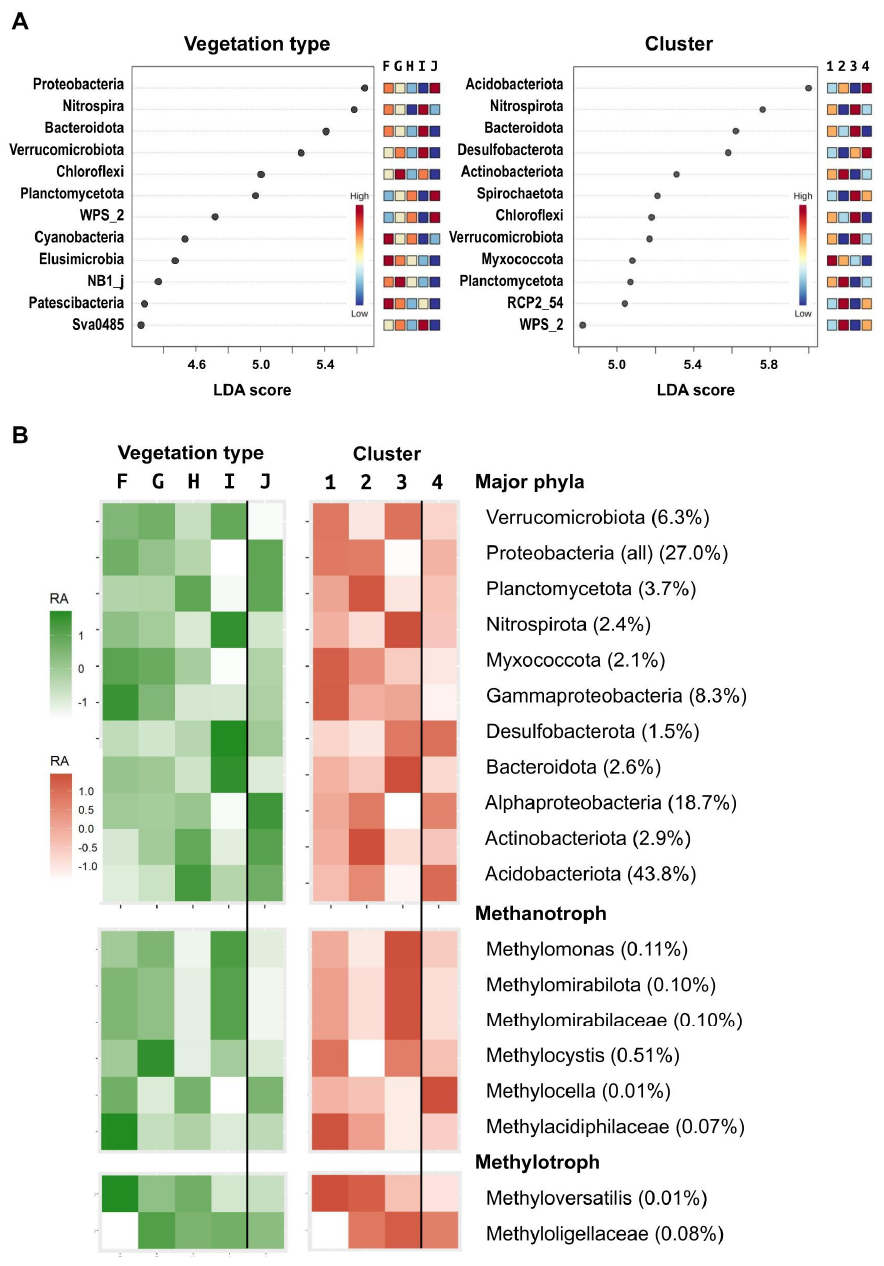
Figure 5. Taxa with differential abundance among samples from distinct vegetation types or PCoA clusters. ( A ) LEfSe analysis results depicting taxa with differential relative abundance among vegetation types ( left ) or PCoA clusters ( right ). The taxa were ranked according to the calculated linear discriminant analysis (LDA) score, as calculated from linear discriminant analysis to illustrate their ability to separate designated groups. ( B ) Bacterial community change along the bog-to-forest gradient. Compositions of the whole community (major phyla) or a particular functional group (methanotrophs, methylotrophs), grouped by either vegetation type ( left ) or PCoA cluster ( right ) are depicted here. Mean relative abundances of that taxon are provided in the label. RA, relative abundance.